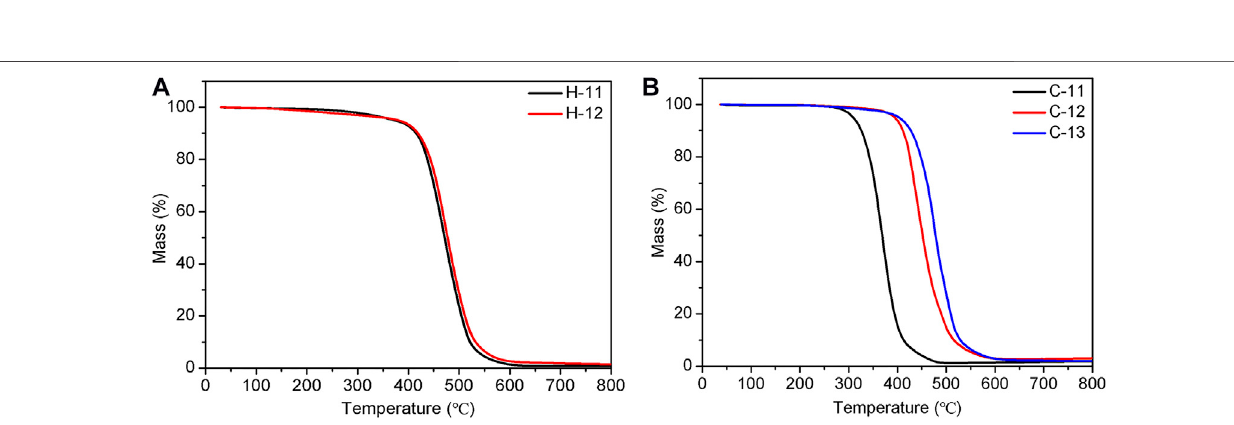
Frontiers in Chemistry |